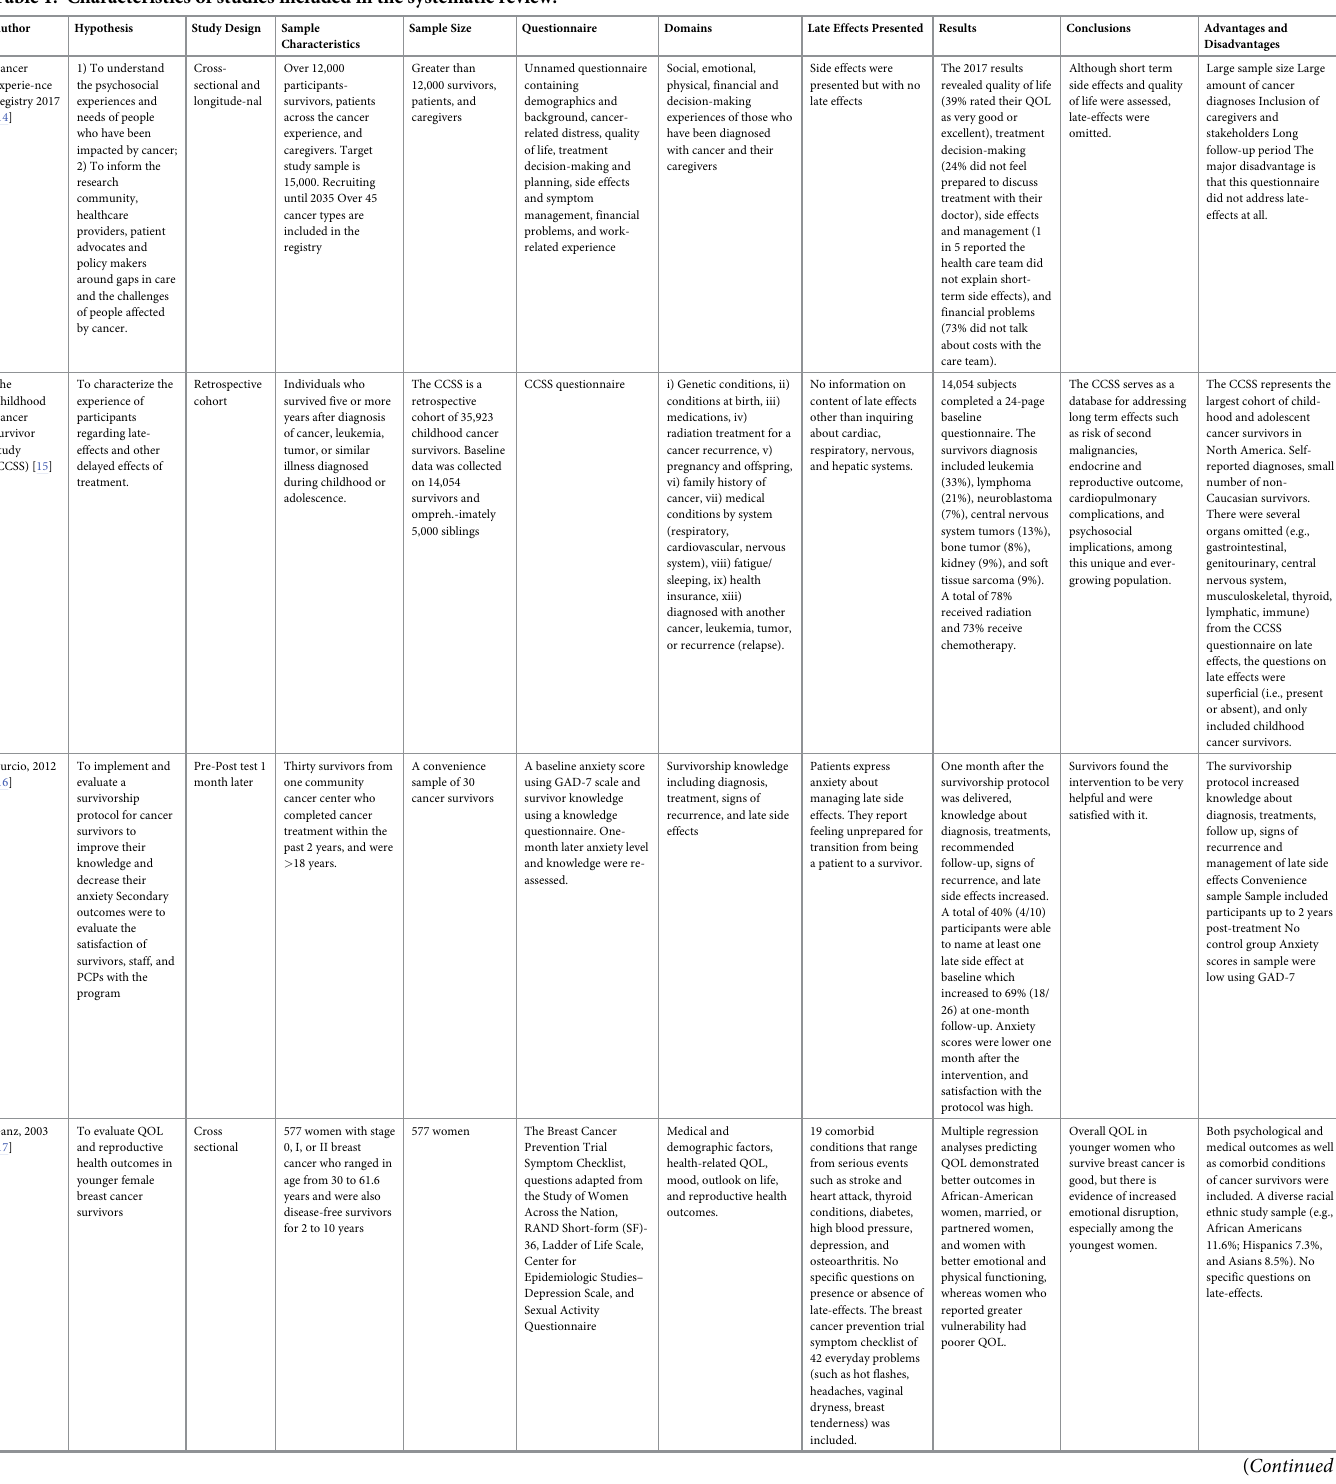
Table 1. Characteristics of studies included in the systematic